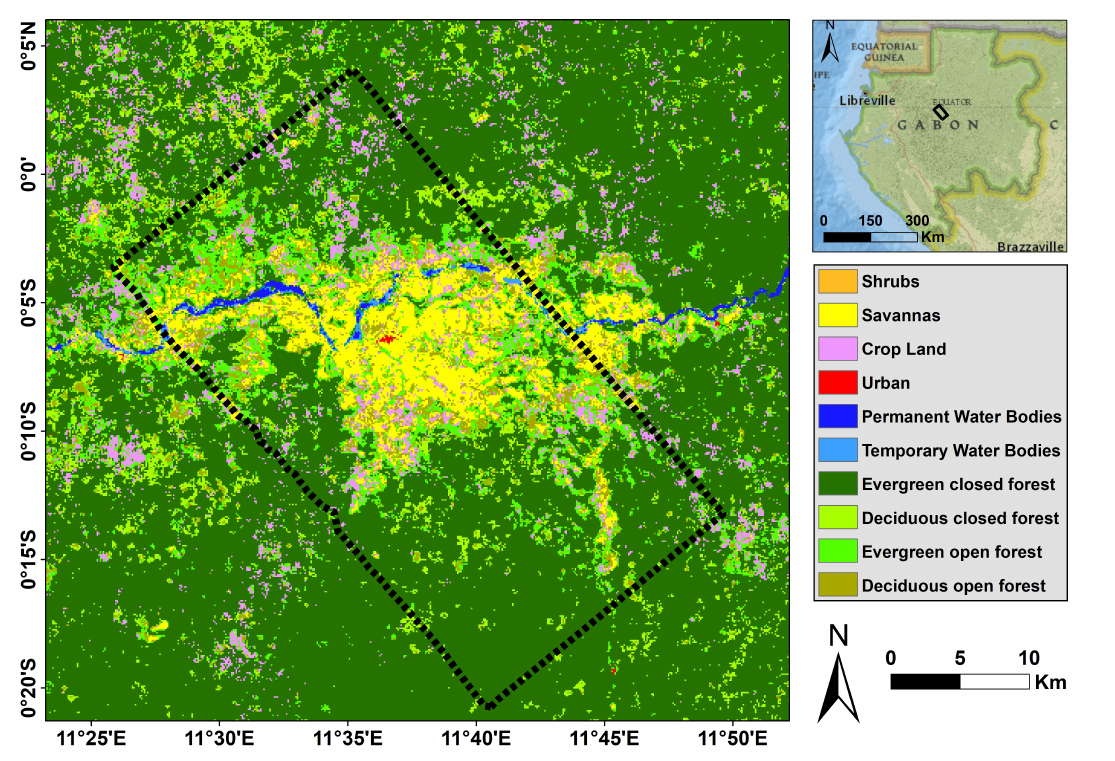
Figure 1. Study area, Gabon Lopé Park. The black polygon represents where UAVSAR acquired L-band TomoSAR data. The background is derived from the Africa Copernicus Land Cover of 100 m × 100 m spatial resolution [26]. The land cover shows different vegetation features of the Lopé National